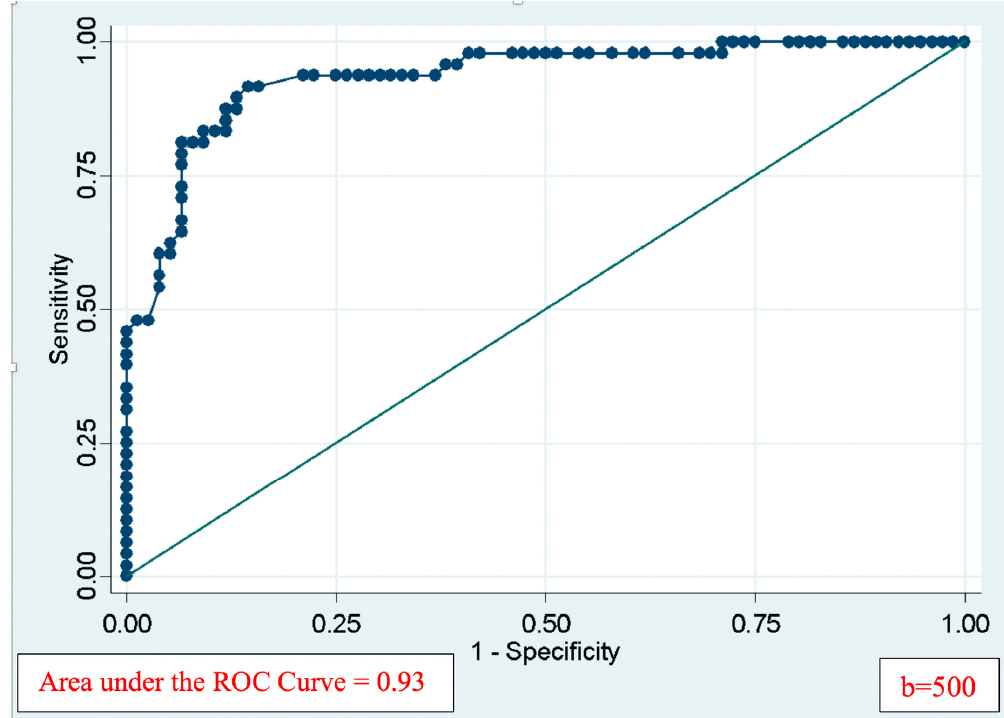
Figure 2. The ROC curve with b = 500, the area under ROC curve = 0.93.